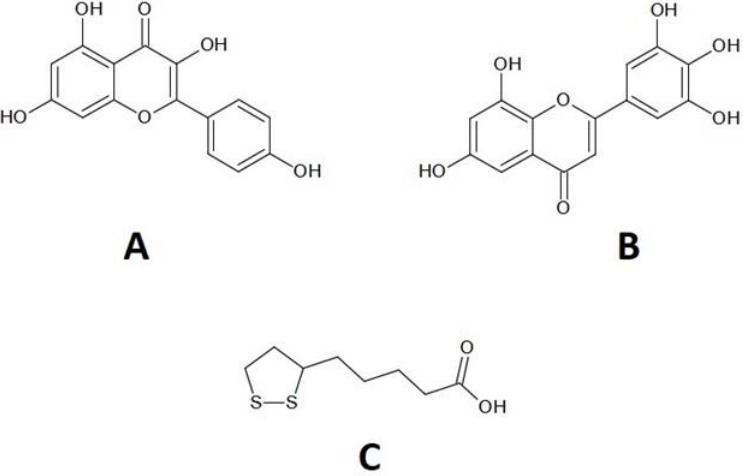
Figure 1. Structure of: ( A ) kaempferol (K), ( B ) myricetin (M), ( C ) lipoic acid (LA).